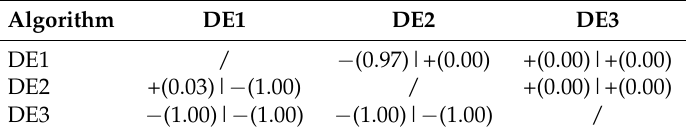
Table 3. eDSC analysis at D*10,000 FEs.